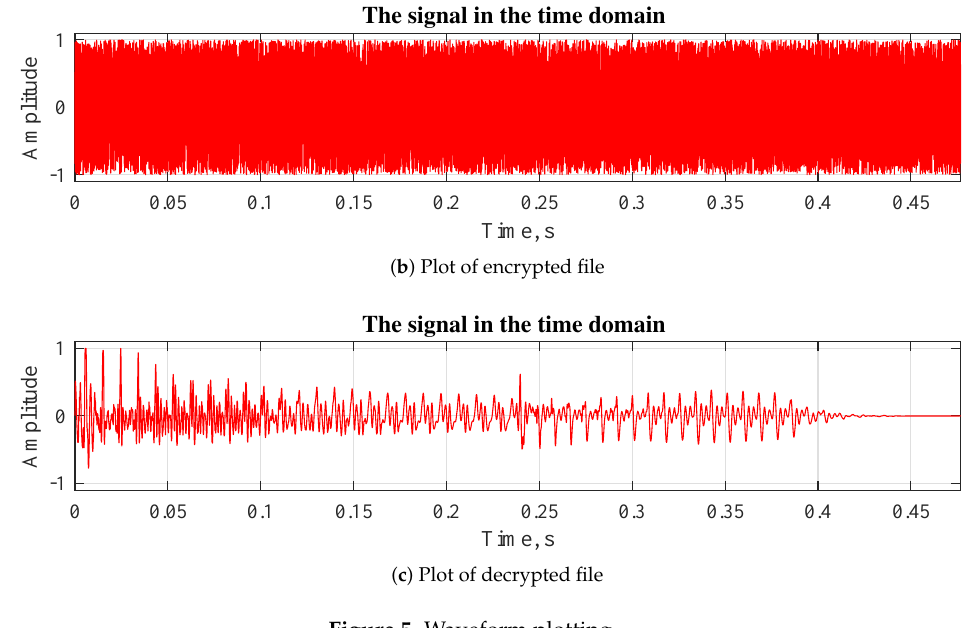
Figure 5. Waveform plotting.